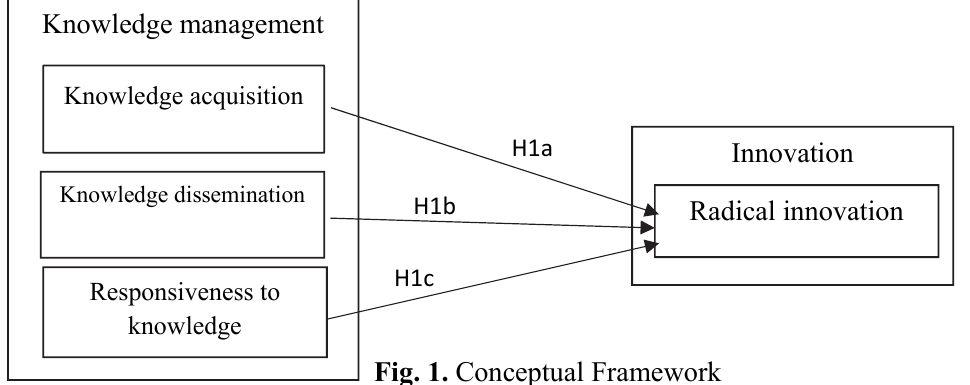
Fig. 1. Conceptual Framework